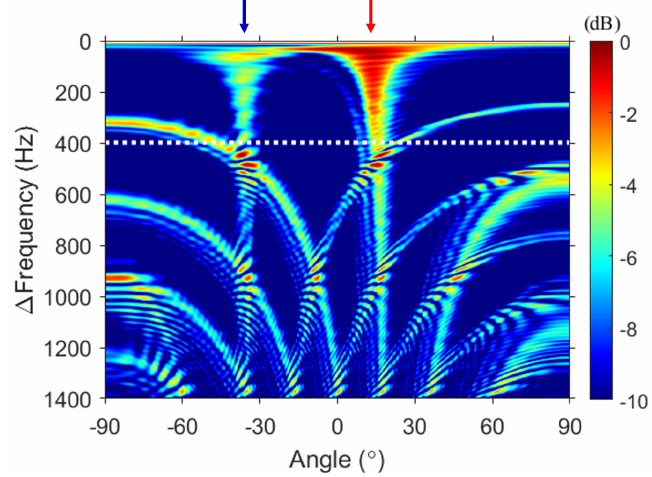
Figure 3. FD beamforming of the simulated data. To minimize the number of unintended terms generated due to the multipath, the FD beamforming outputs are averaged over the signal frequency band (i.e., 11–22.6 kHz), resulting in two distinct vertical lines between 60 ◦ and 30 ◦ . The red and blue arrows indicate the DOAs corresponding to the direct and surface-reflected paths, respectively. The two arrows are aligned with the angle represented by the two vertical lines, showing that FD beamforming can estimate the DOAs of a sparse vertical array configuration.